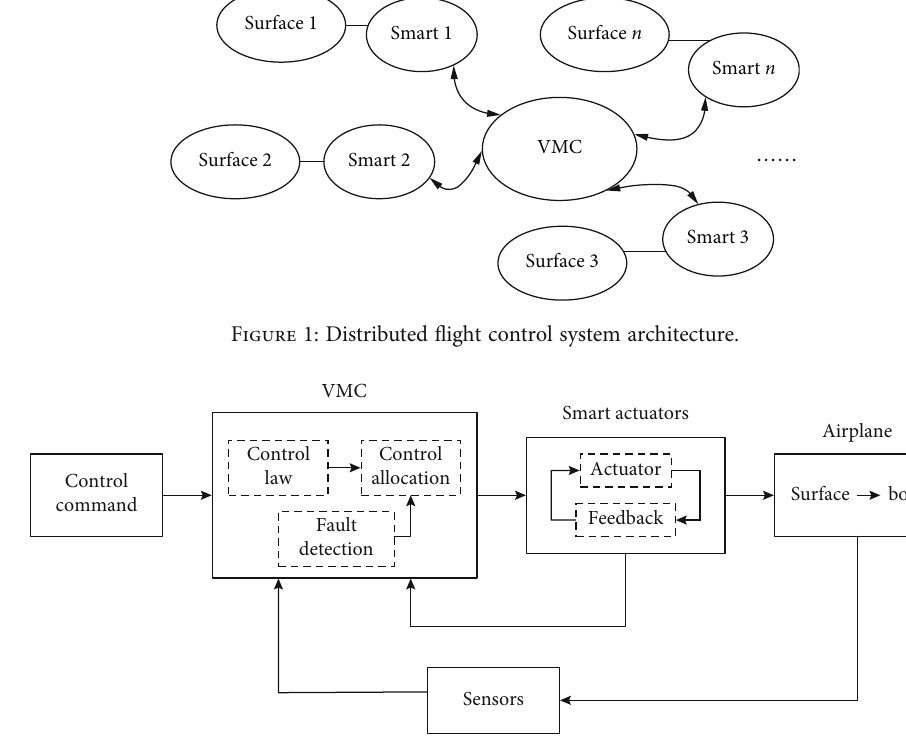
Figure 2: Recon fi guration control block diagram based on control allocation